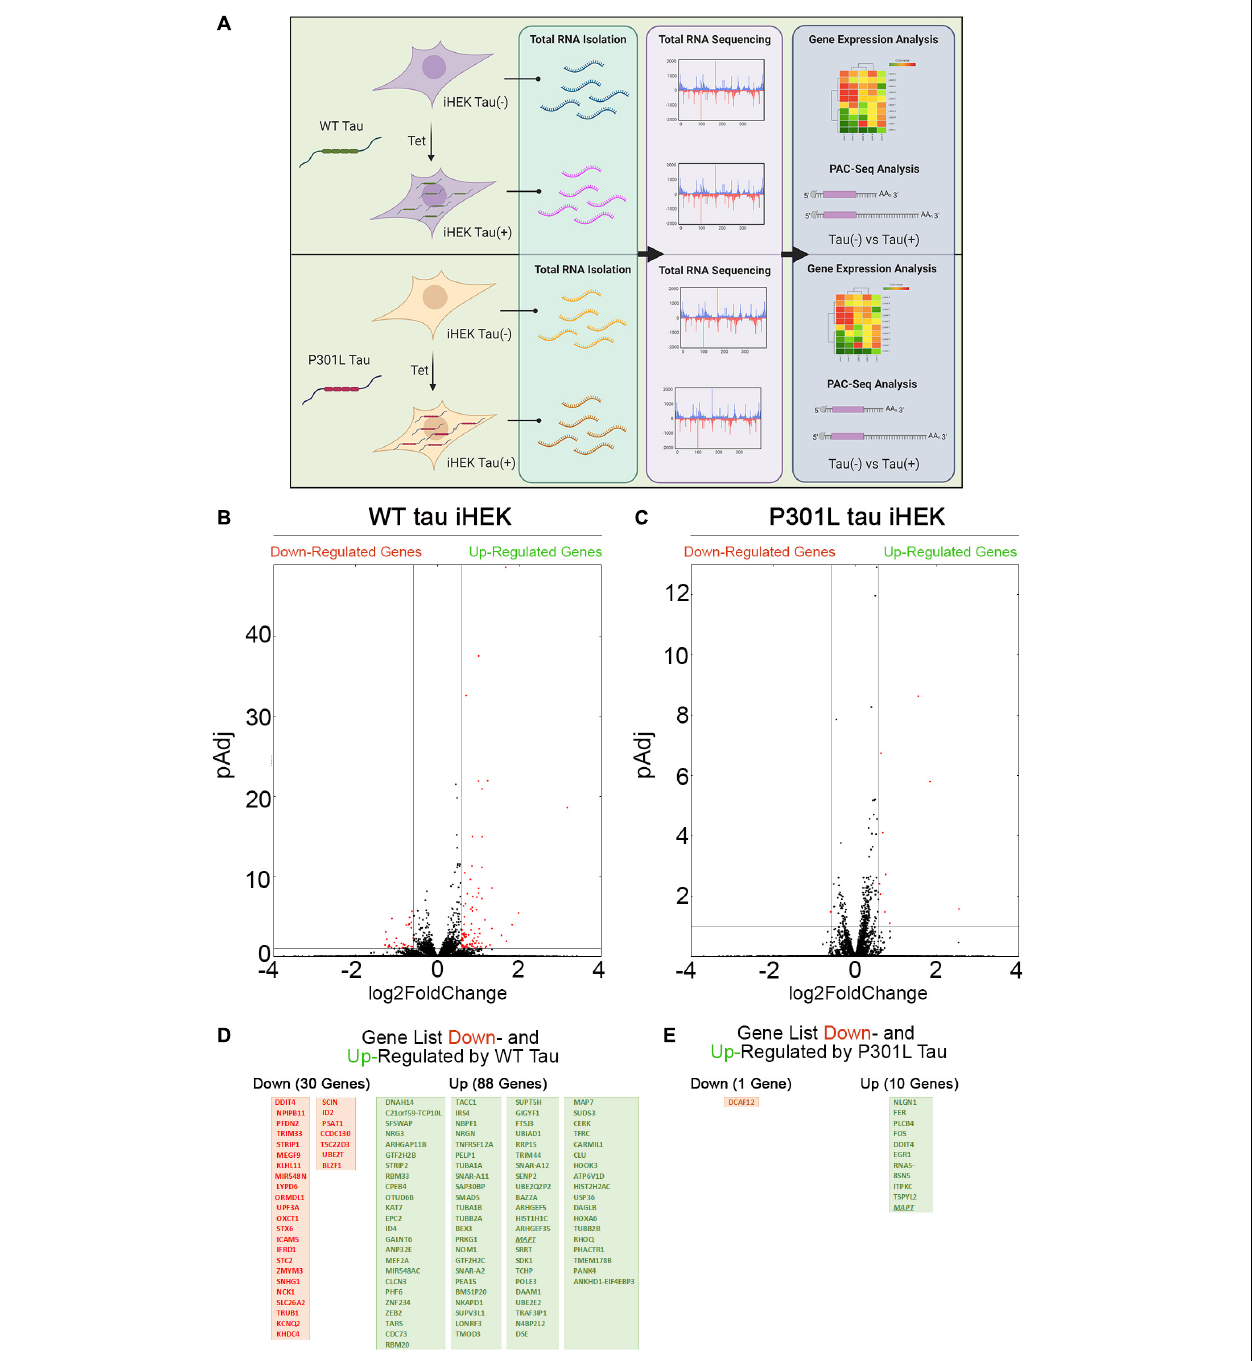
FIGURE 1 | Tau-dependent Gene expression. (A) Schematic representation of experimental plan, from Tet induction in WT and P301L Tau iHEK to RNA isolation, sequencing to gene expression analysis. (B) Volcano Plot for Down- and Up-regulated gene in WT tau iHEK. (C) Volcano Plot for Down- and Up-regulated gene in P301L tau iHEK. (D) Gene Lists of Down-Regulated (Red Boxes) and Up-Regulated (Green Boxes) Genes in WT tau iHEK. (E) Gene Lists of Down-Regulated (Red Boxes) and Up-Regulated (Green Boxes) Genes in P301L tau iHEK.